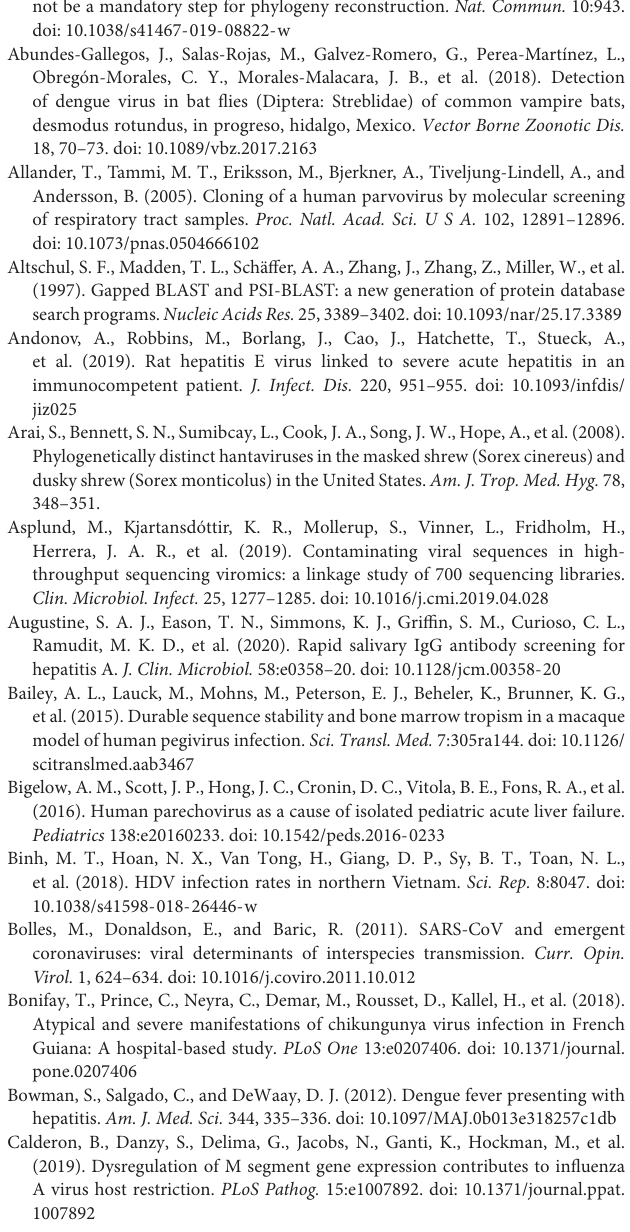
Cantalupo, P. G., and Pipas, J. M. (2019). Detecting viral sequences in NGS data. Curr. Opin. Virol. 39, 41–48. doi: